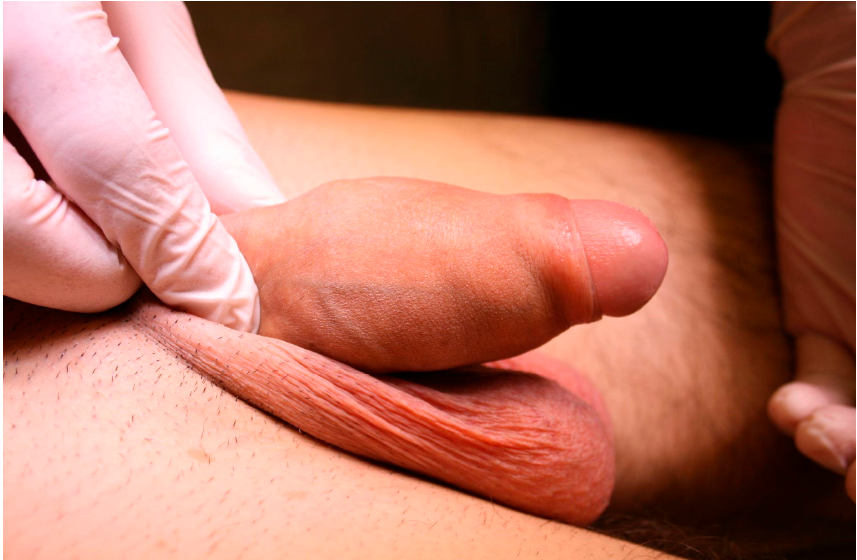
Figure 1. Swollen and phimotic penis.